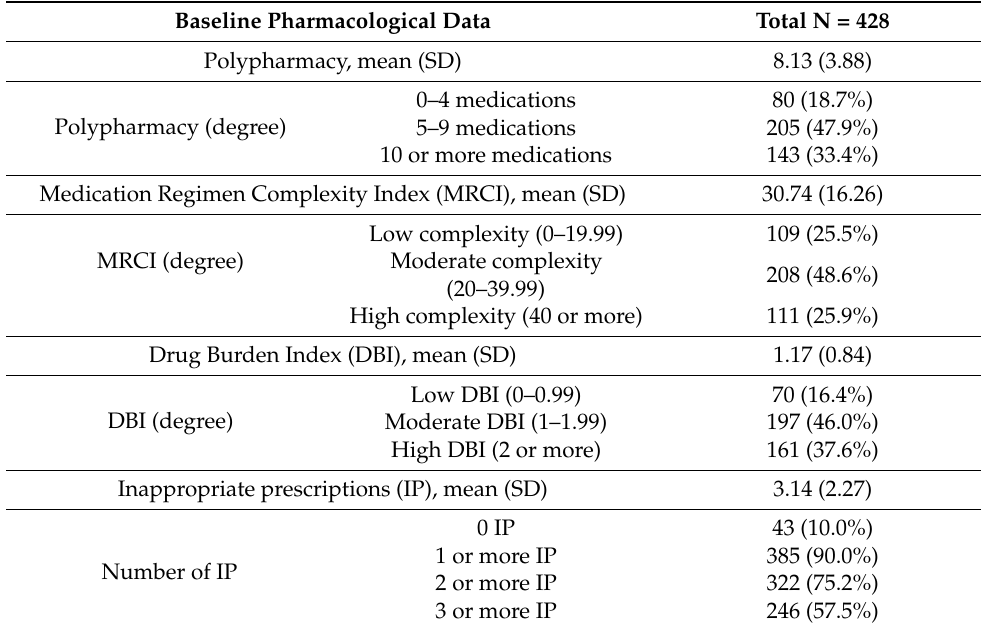
Table 3. Baseline pharmacological data for the COP-cohort.